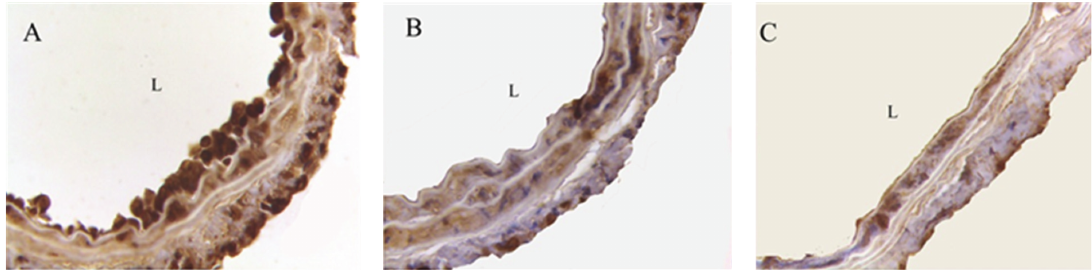
Figure 3: Photomicrographs of CD45 immunostaining showing injured carotid arteries from PPAR α knockout mouse, WT mouse, and WT mouse treated with Wy14643 at day 4 after injury (63x). (A) Representative cross-section of CD45 expression from PPAR α knockout group. (B) Representative cross-section of CD45 expression from WT group. (C) Representative cross-section of CD45 expression from WT treated with Wy14643 group. More extensive CD45 expression was observed in PPAR α knockout mouse when compared to WT mouse. The treatment with Wy14643 further decreased CD45